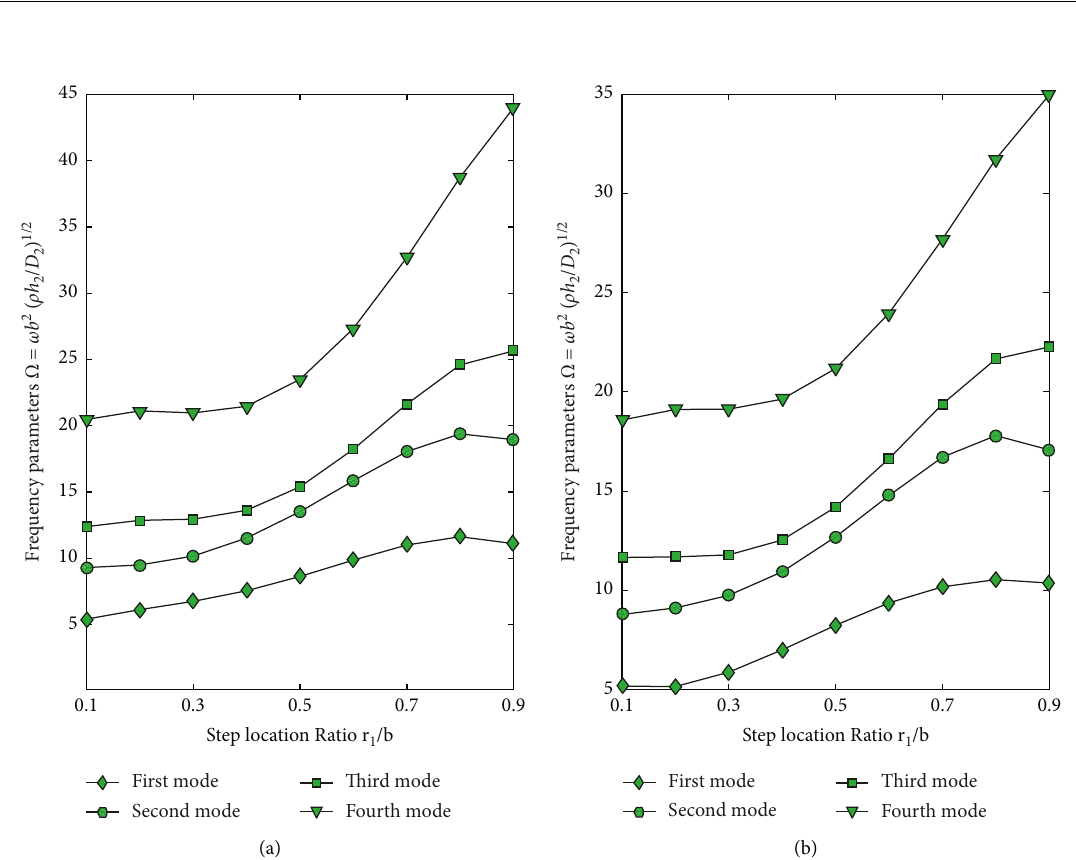
������ 􏽰 ρ h versus step location ratio r / D 2 2 / b � (a) 0.006 and (b) 0.15. 1